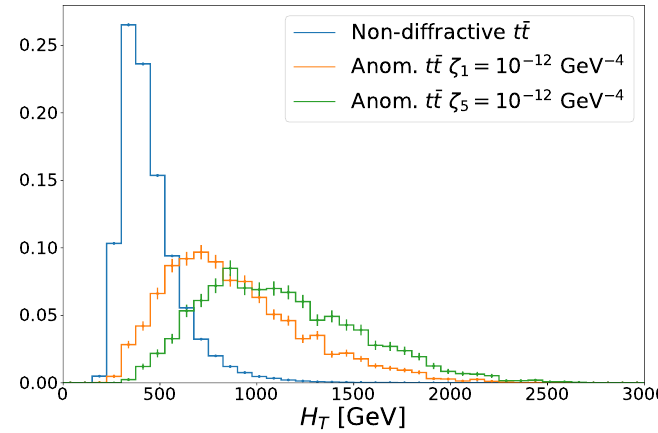
Figure 7. Sum of the transverse momenta of the decay products of the t ¯ t system ( H T ). Only events passing the pre-selection are shown. Histograms are normalized to